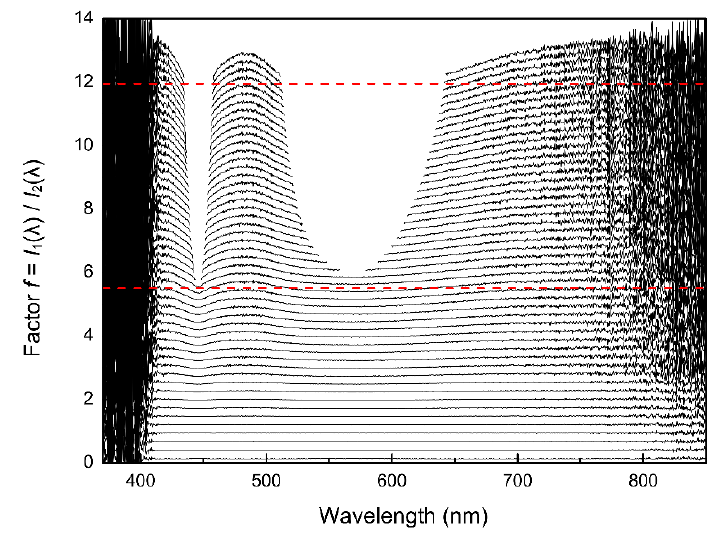
Figure 6. Qualitative illustration of the non-linearities of the CCD detector. The ratios f of I 1 (λ) to I i (λ) are plotted versus the wavelengths (nm) for several integration times. In theory, the f ratios should be constant for all wavelengths of a spectrum. The dashed red lines are the expected characteristics for two arbitrarily chosen integration times, the black lines are the observed characteristics for several integration times (compare also with Figure 11).